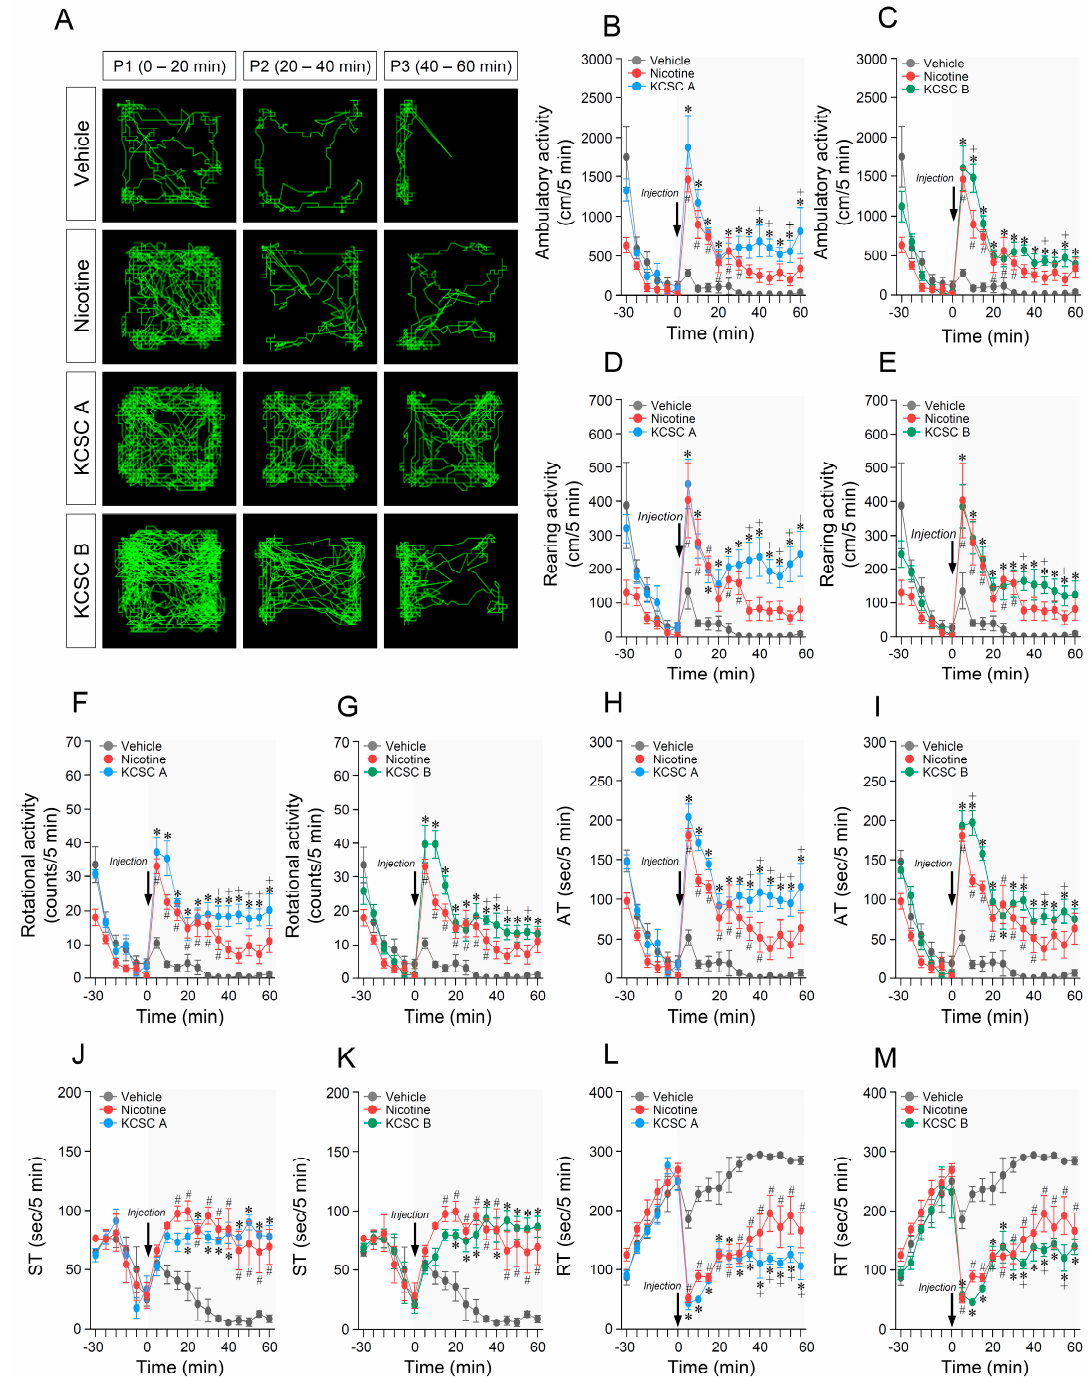
Figure 4. Prolonged changes in behavioral activities after challenge administration of two KCSCs. Statistical significance was determined by two-way RM-ANOVA and multiple comparison test with Bonferroni’s post-hoc test. # p < 0.05, vehicle challenge group vs. nicotine challenge group; * p < 0.05, vehicle challenge group vs. KCSC challenge groups; + p < 0.05, nicotine challenge group vs. KCSC challenge groups. WD, withdrawal; CH, challenge; AT, ambulatory time; ST, stereotypy time; RT, resting time. n = 6 per group.